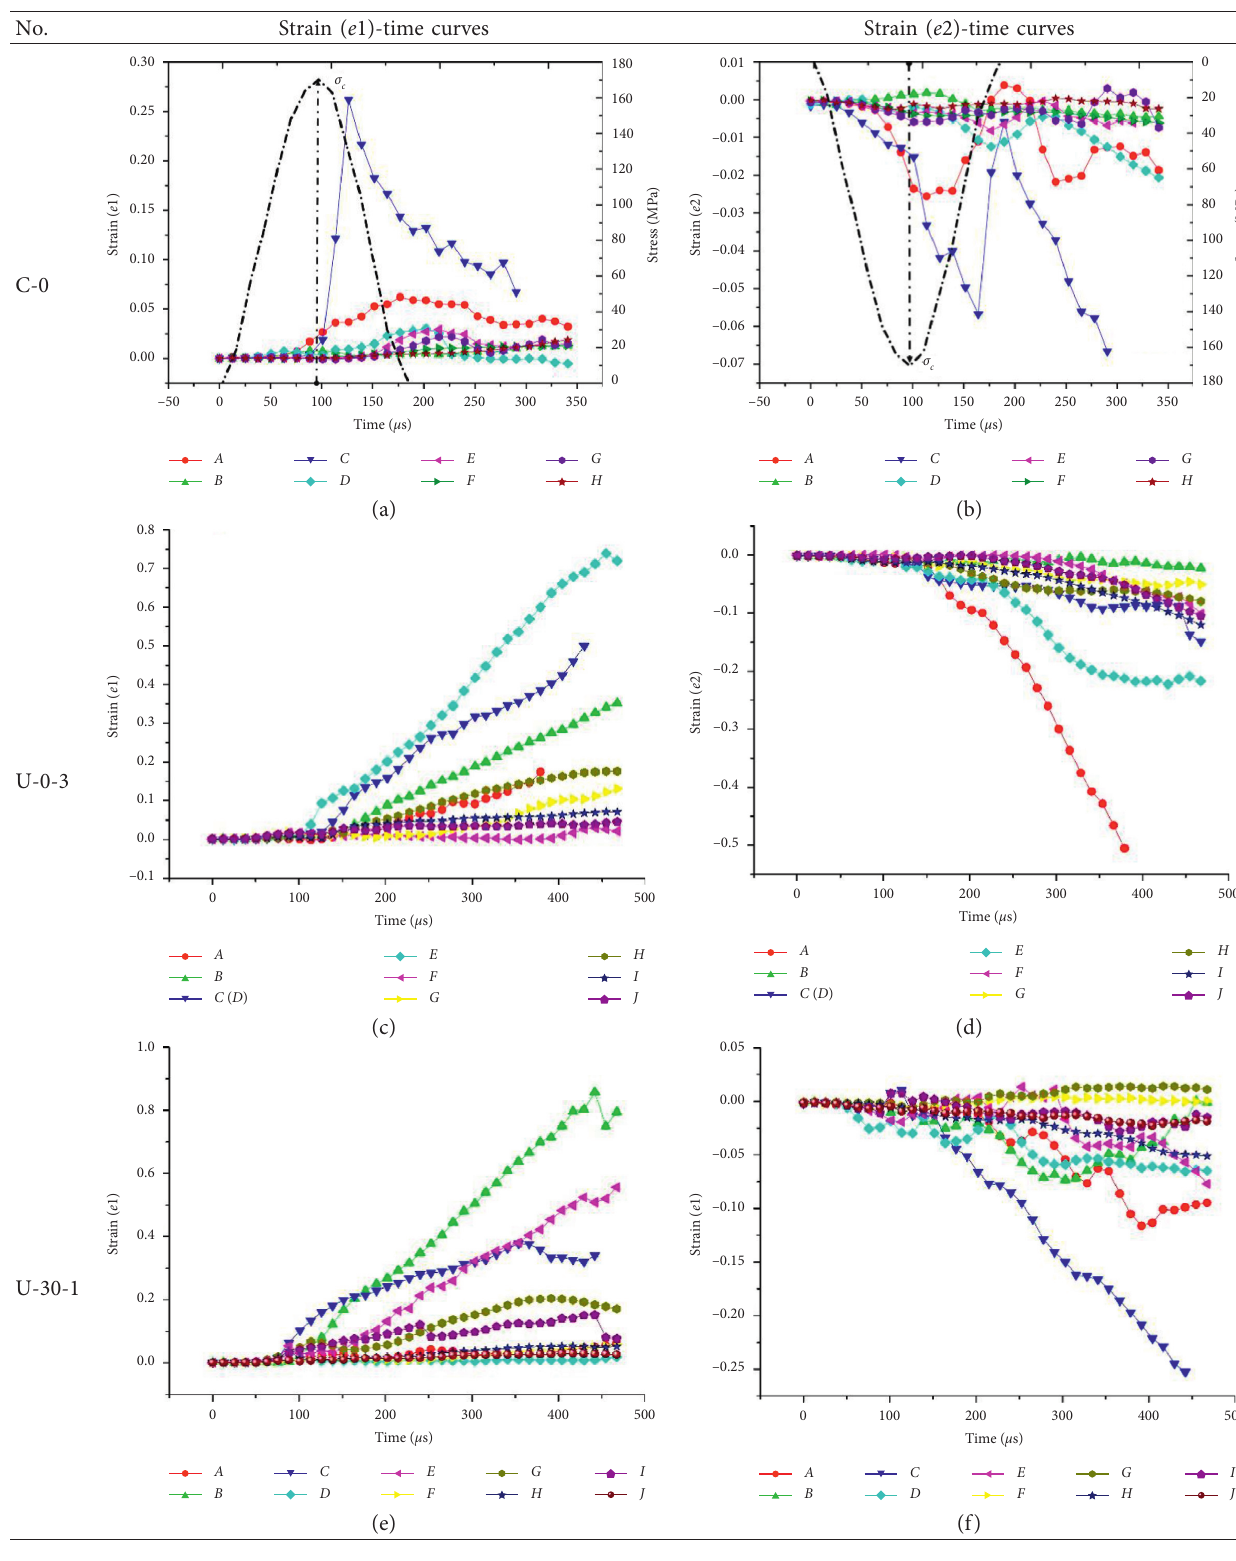
Table 5: Strain-time evolution curves of the measurement points in typical